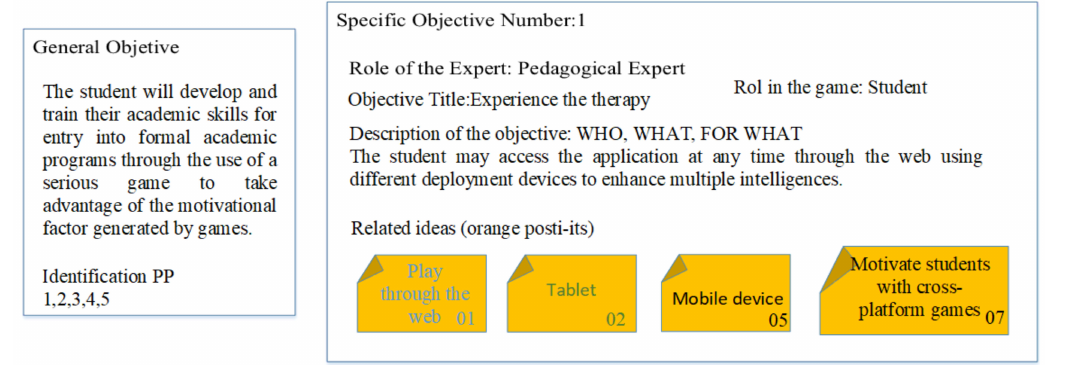
Figure 12. Description of the general objective and the specific